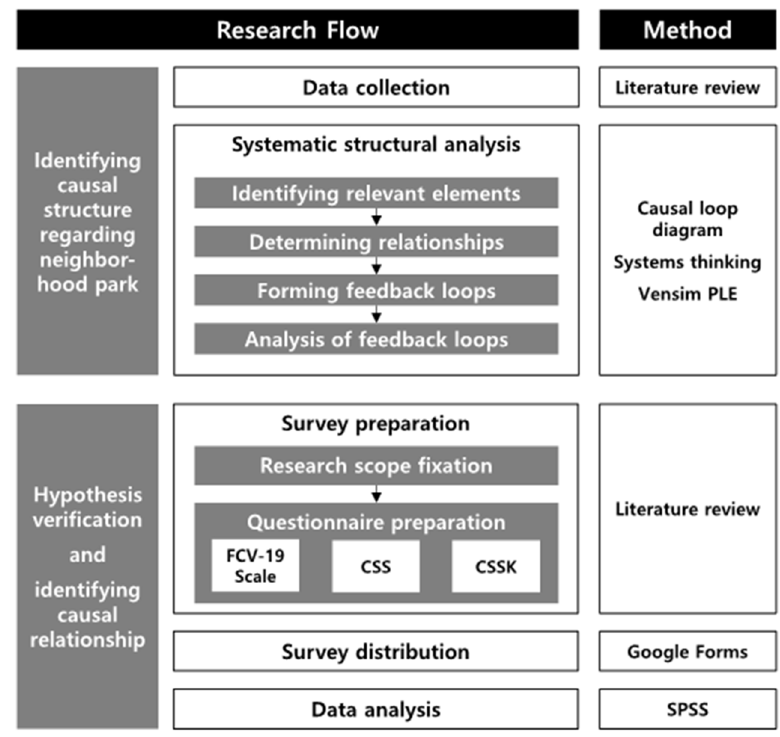
Figure 1. Research